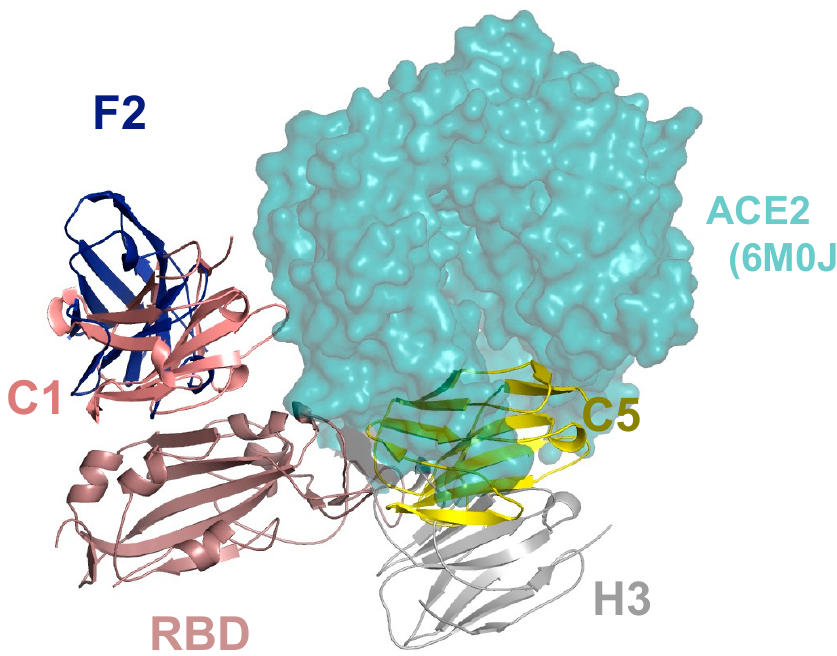
Figure 3. Montage of RBD–nanobody X-ray complexes with location of ACE-2 binding. The four nanobodies are shown in cartoon and labelled. The figure was generated by superimposing the RBD protein from each crystal structure, only one RBD monomer is shown. Also shown is ACE2 (cyan surface) from the RBD ACE2 complex (PDB 6M0J), positioned by superposition of the RBD.